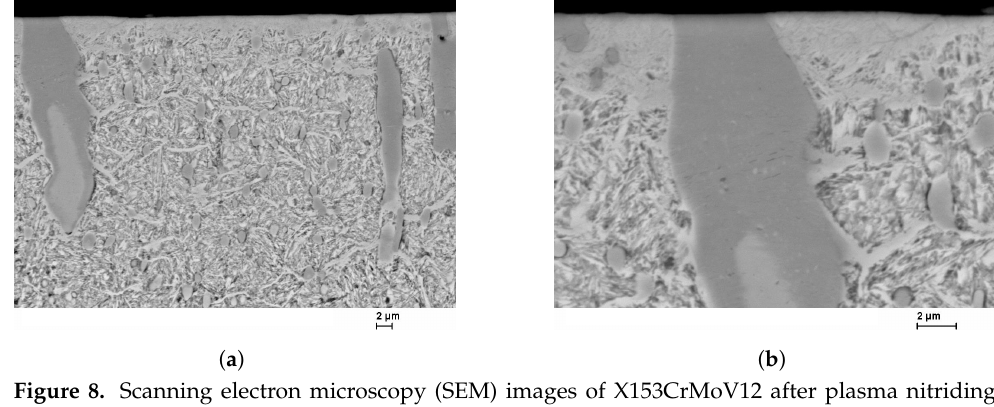
Figure 8. Scanning electron microscopy (SEM) images of X153CrMoV12 after plasma nitriding at 560°C and a duration of 2h with different magnifications. In ( a ) partially transformed car- bides/nitrides are visible in the martensitic matrix. ( b ) shows a detailed view of the carbide/nitride at a higher magnification. These images illustrate the heterogeneous behavior of nitrogen diffusion in a high-alloy tool steel due to the heterogeneous